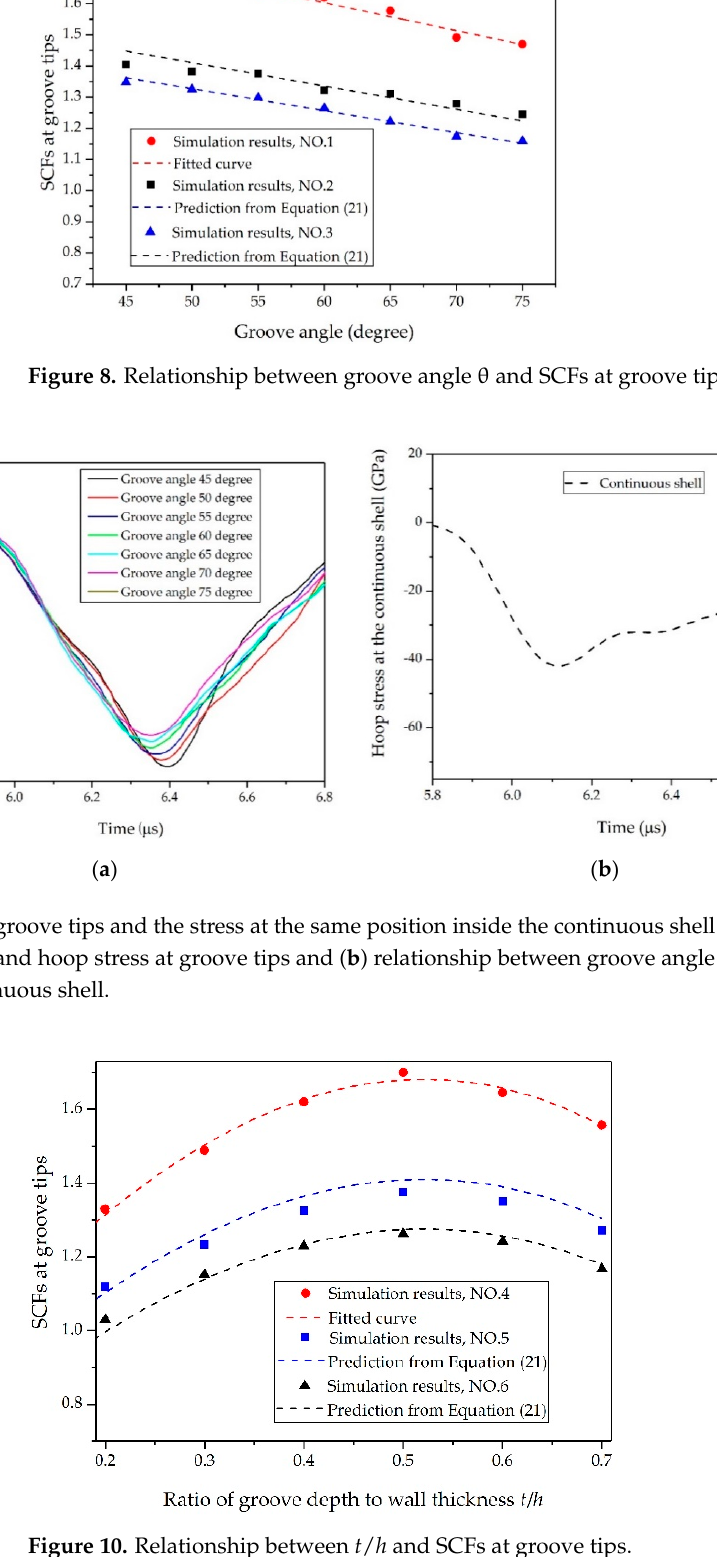
Figure 11. Propagation of the transmitted stress waves along the inclined groove wall.